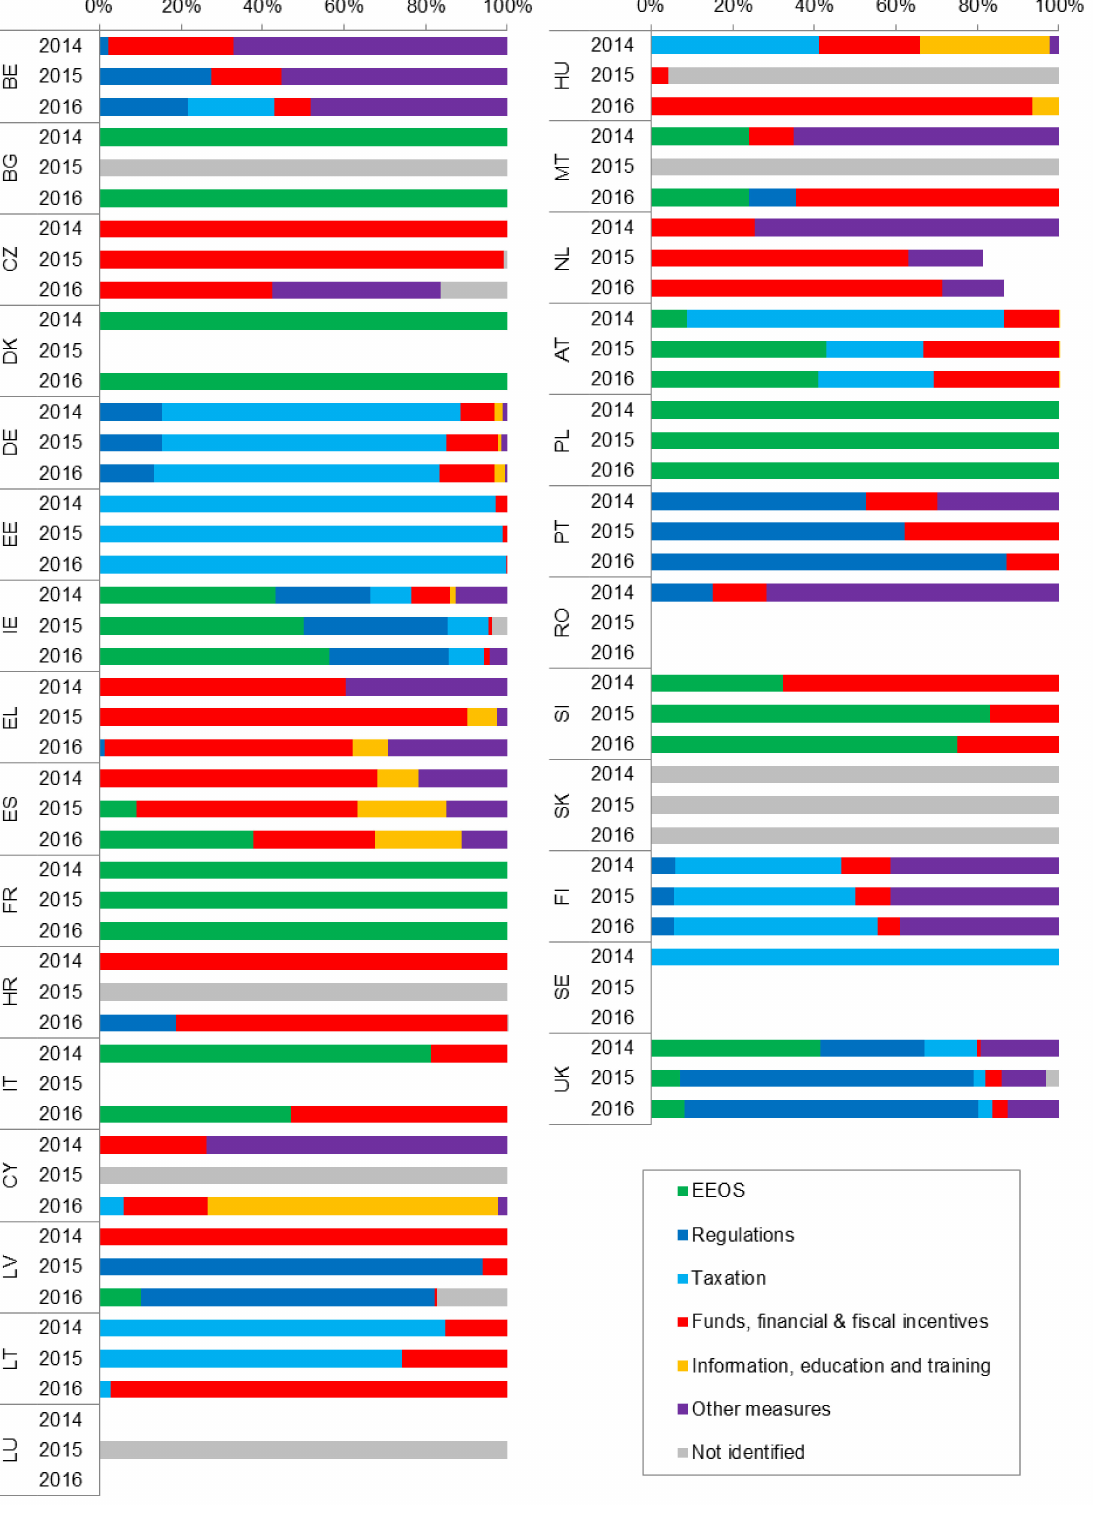
Figure 2. Share of energy savings generated in 2014, 2015 and 2016 by new actions that were implemented in these years, by type of policy measure. The absence of bars means that also total new savings have not been